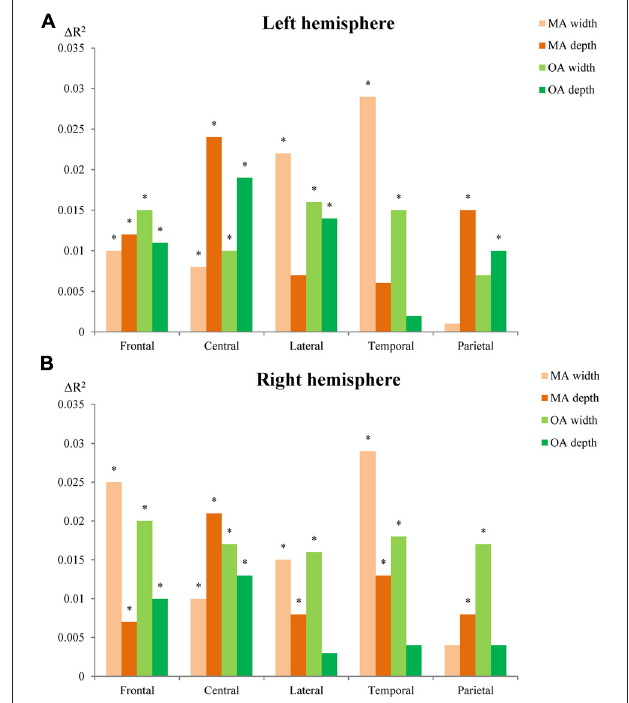
FIGURE 6 | Sensitivity of sulcal width and depth to local brain volumetric differences in the left (A) and right (B) hemispheres. MA, Middle age; OA, old age. The R-squared changes ( ∆ R 2 ) indicate changes of explanatory power between models with and without sulcal width or depth (proportion of variability in the local gyral volumes explained by sulcal width or depth). ∗ Indicates significant association ( p < 0.01) between local gyral volumes and sulcal width or